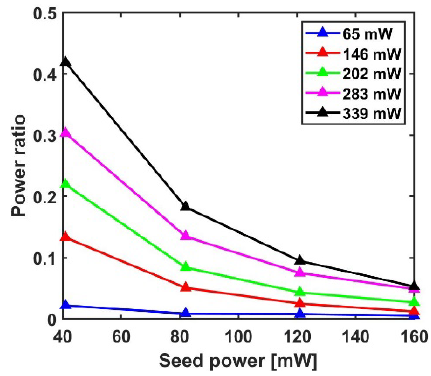
Figure 5. The variation of the power ratio of in-band ASE to signal power with the seed power.